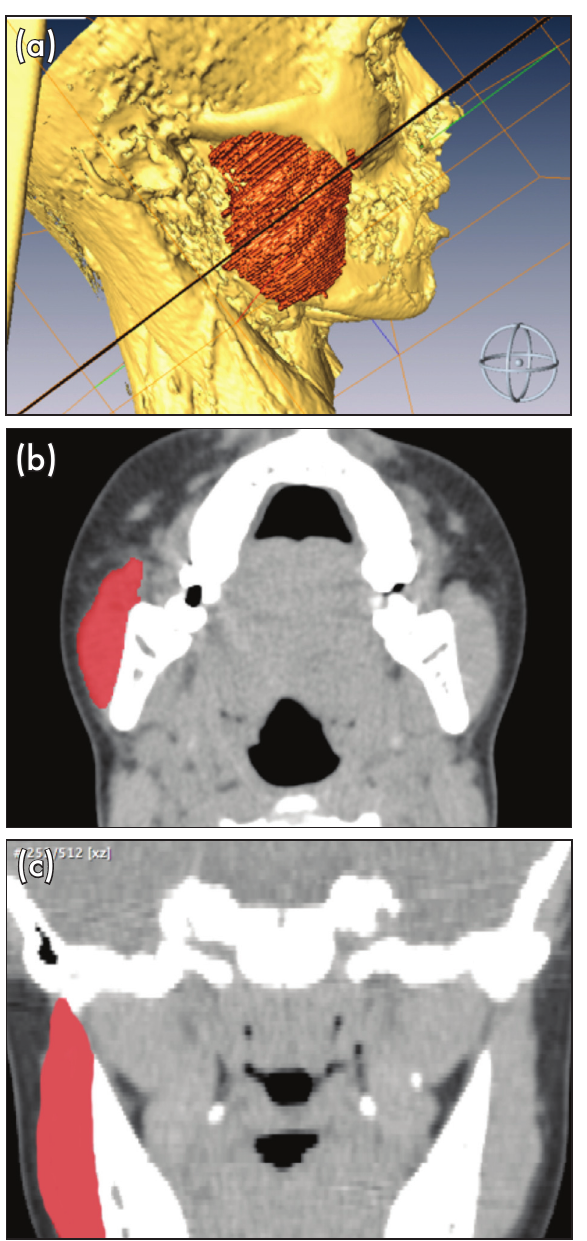
Figure 4. Estimation of masseter muscle volume: (a) composites of all muscular outlines from digitally-traced sequential axial CT images, represented in 3D; (b) superior view; (c) frontal view.